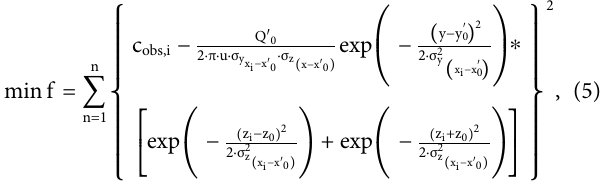
FIGURE 2 | Flowchart of performance evaluation of source